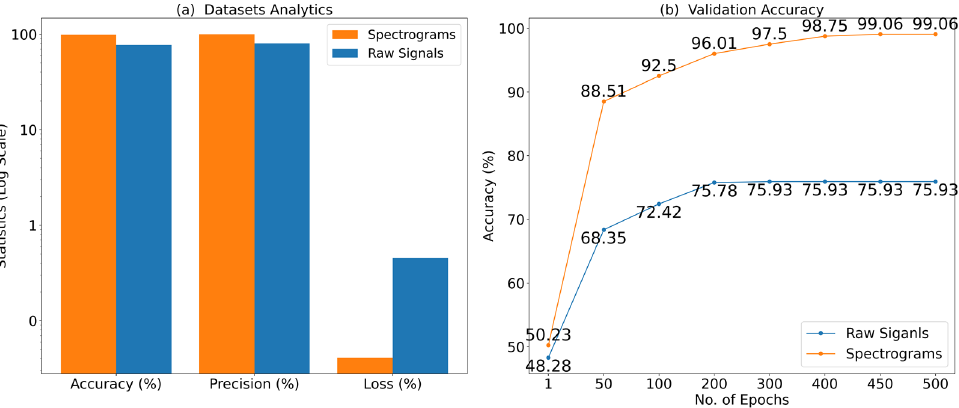
Figure 6. ( a ) Data analytics: accuracy, precision, and loss in log scale for both datasets: raw signals and spectrograms, ( b ) validation accuracy: x -axis (no. of epochs), y -axis (accuracy) for both datasets: raw signals and spectrograms.